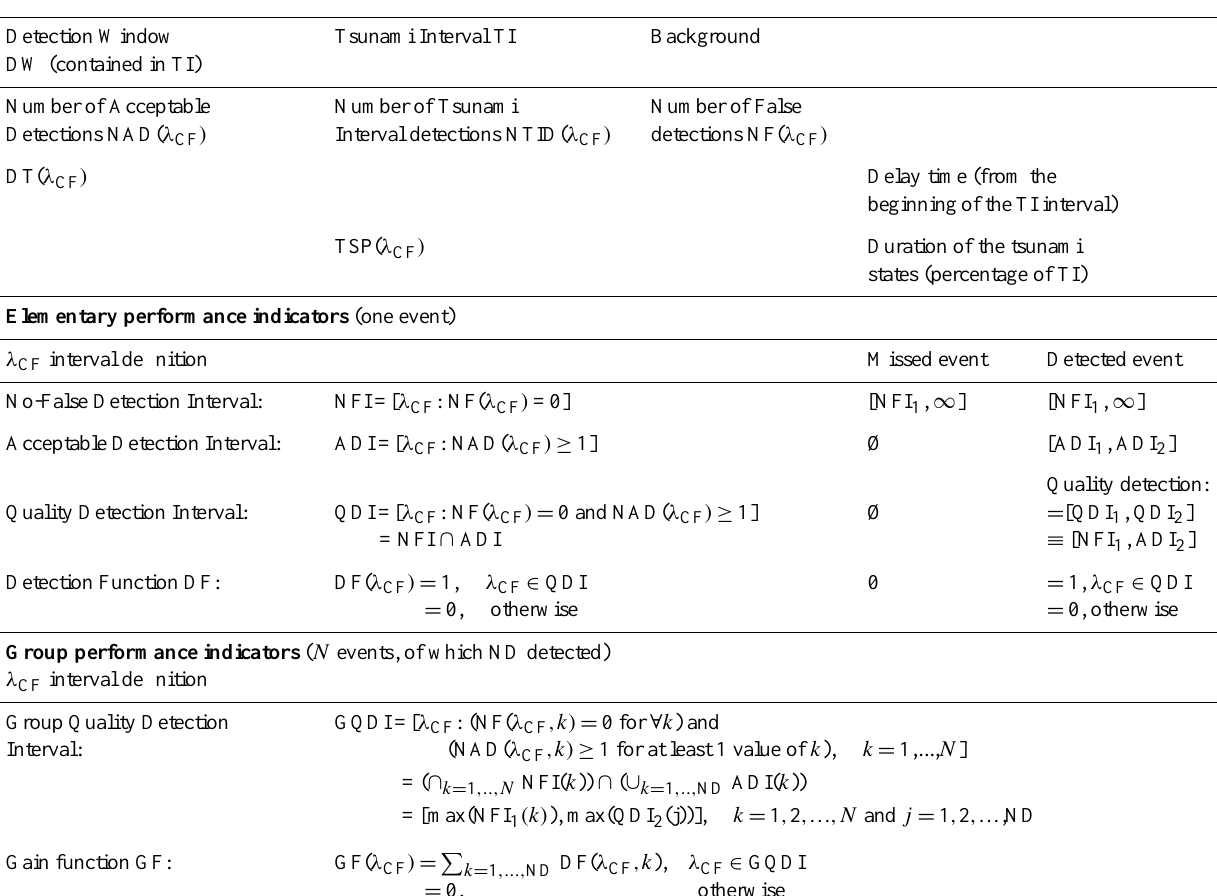
Table 1. Scheme of TEDA performance